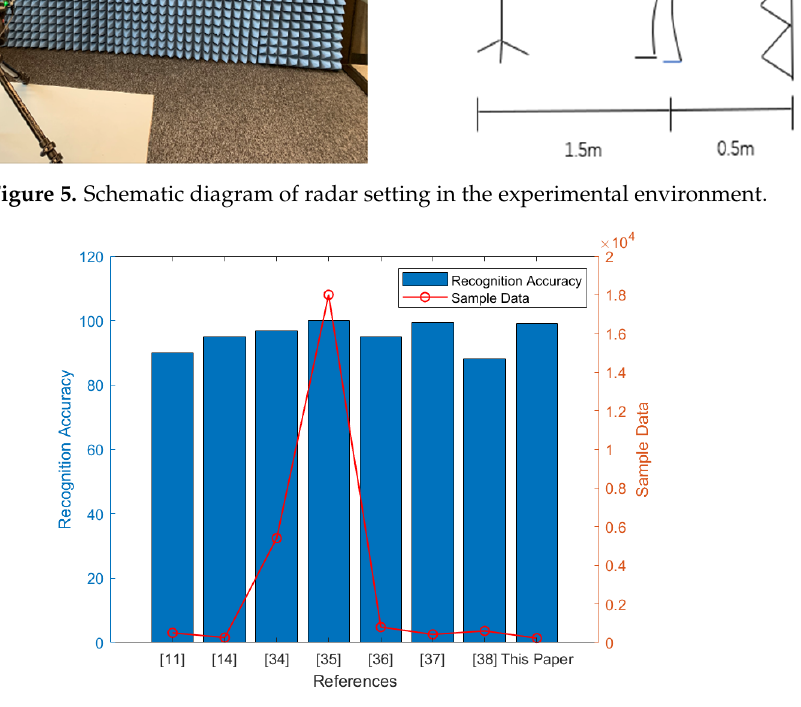
Figure 6. Schematic diagram in human pose recognition analysis